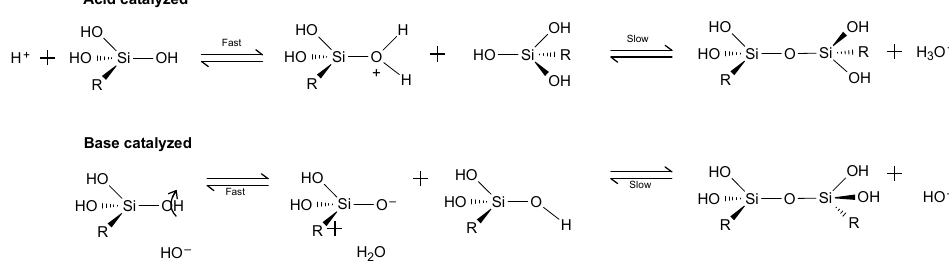
Figure 3. Different mechanisms of reactions of the hydrolysis catalyzed by an acid and a base.